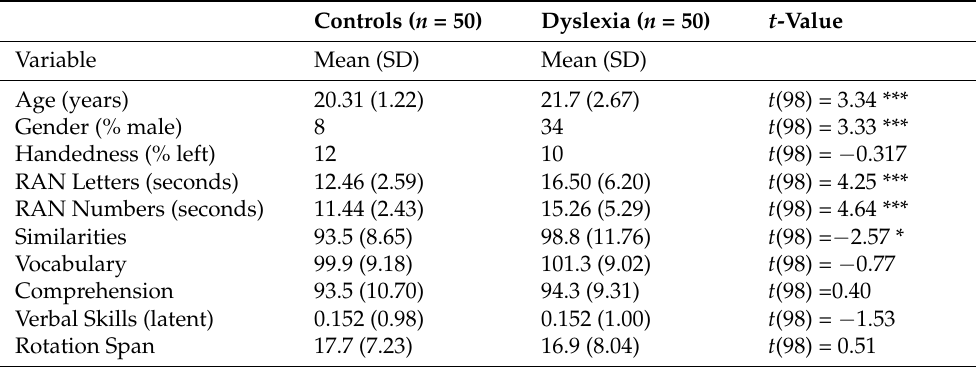
Table 2. Means and standard deviations for demographic variables, the Rapid Automatised Naming task and the individual differences variables. Controls ( n = 50) Dyslexia ( n = 50) t -Value Variable Mean (SD)